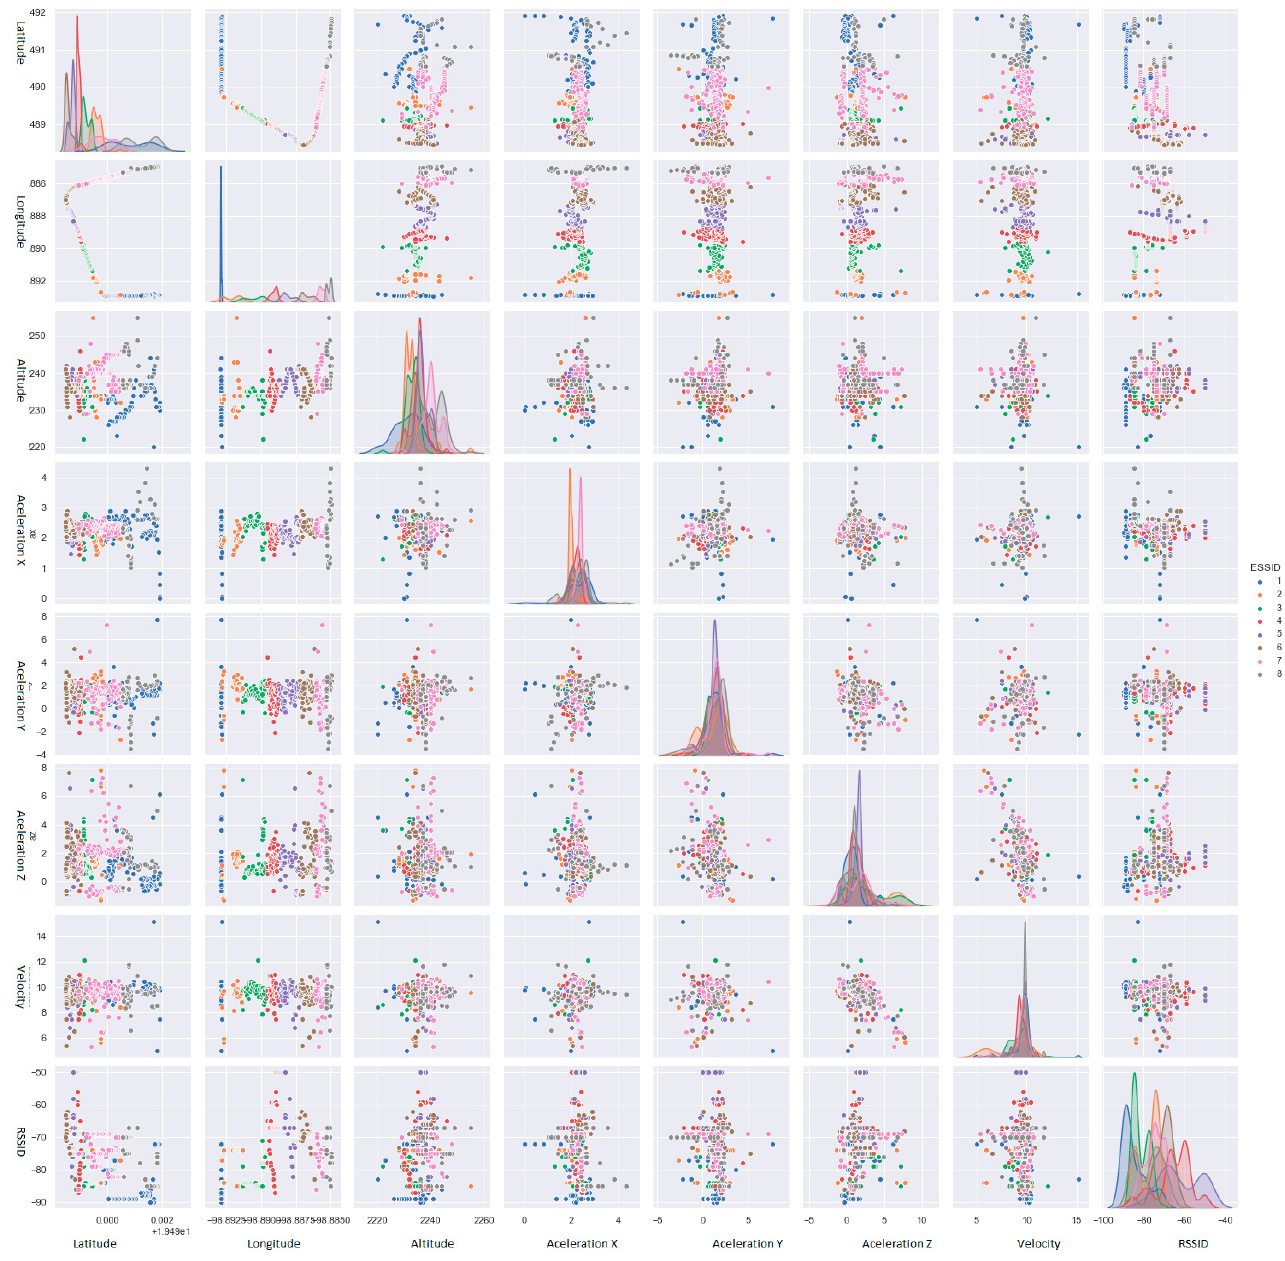
Figure 12. Estimated feature comparison chart.